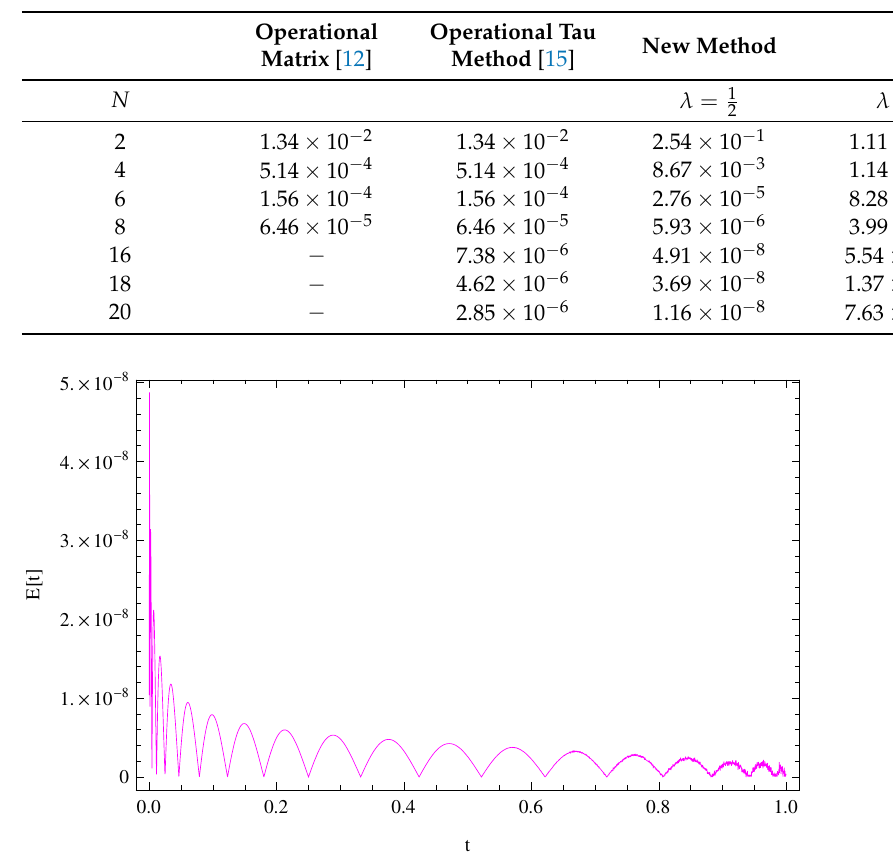
Figure 7. The E ( t ) of Example 4 for N = 20, λ = 1